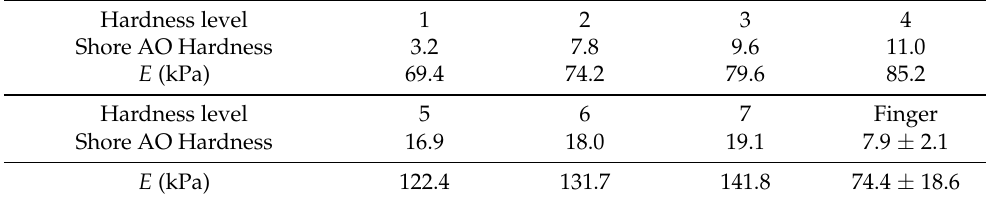
Table 1. Young’s moduli ( E ) and Shore AO hardness of artificial skin models and human fingers. For the finger, the mean and standard error are